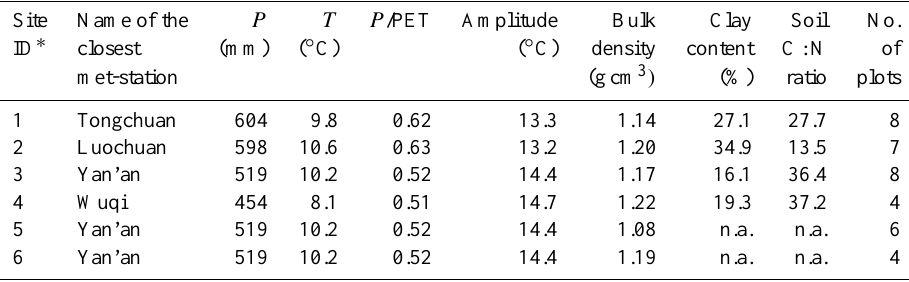
Table 1. Description of site characteristics: P – annual precipitation, T – annual mean temperature, PET – potential evapotranspiration, Amplitude – inter-annual temperature change, C:N ratio of soil total carbon to nitrogen. Soil property parameters are for soil depths 0– 20cm.